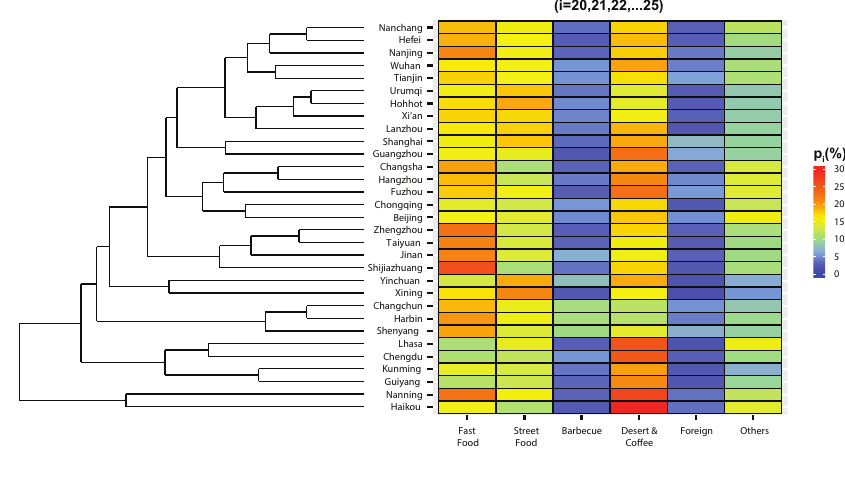
Figure 6. Percentage of restaurants in each individual city organized by other culinary styles (type 20 to type 25). The dendrogram illustrates similarities between